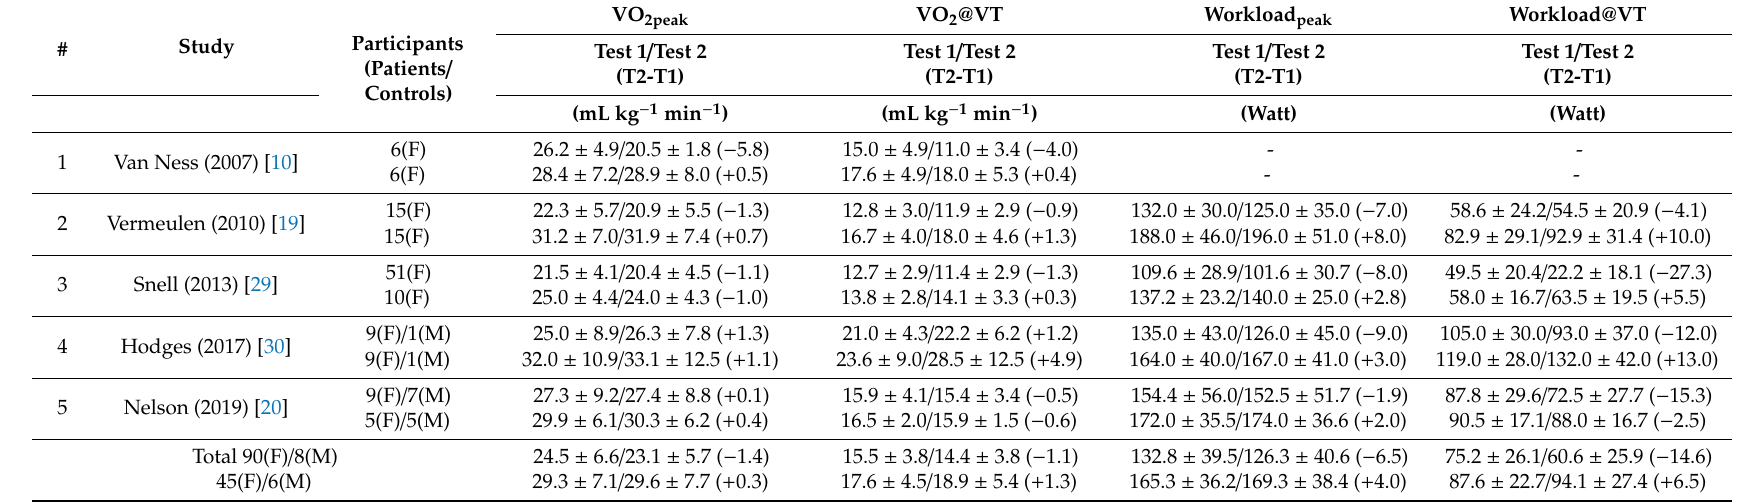
Table 2. Studies that performed the two-day cardiopulmonary exercise test (CPET) in ME / CFS patients and